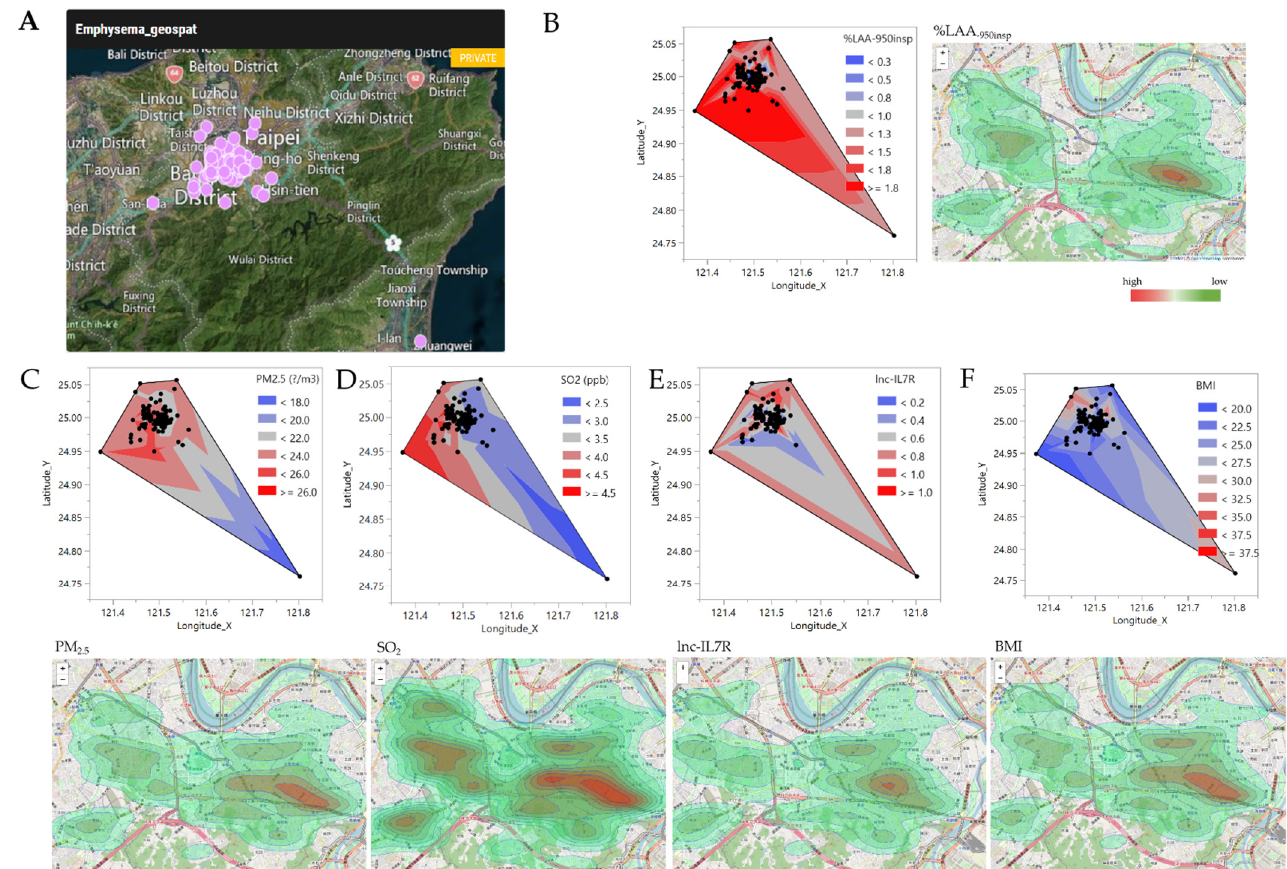
Figure 6. Low BMI, and lnc-IL7R, with concomitant high PM 2 . 5 , and SO 2 levels is pathognomonic of exacerbated/severe COPD-E in New Taipei City, Taiwan. ( A ) Image of the geospatial mapping patients with COPD-E in New Taipei City. Contour-based polygon plots and heatmap aerial view maps of case distribution according to ( B ) disease severity, and levels of ( C ) PM 2 . 5 , ( D ) SO 2 , ( E ) lnc-IL7R, and ( F ) BMI in patients with COPD-E in New Taipei City.